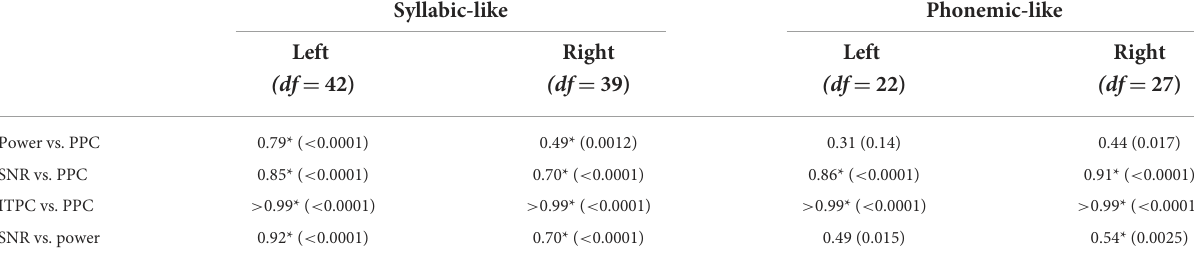
TABLE 2 Pearson’s correlation coefficients between different electrophysiological metrics of syllabic-like and phonemic-like TEMPEST neural responses in the left and right hemispheric channels. Syllabic-like Phonemic-like Left Right Left Right (df = 42) (df = 39) (df = 22) (df = 27)